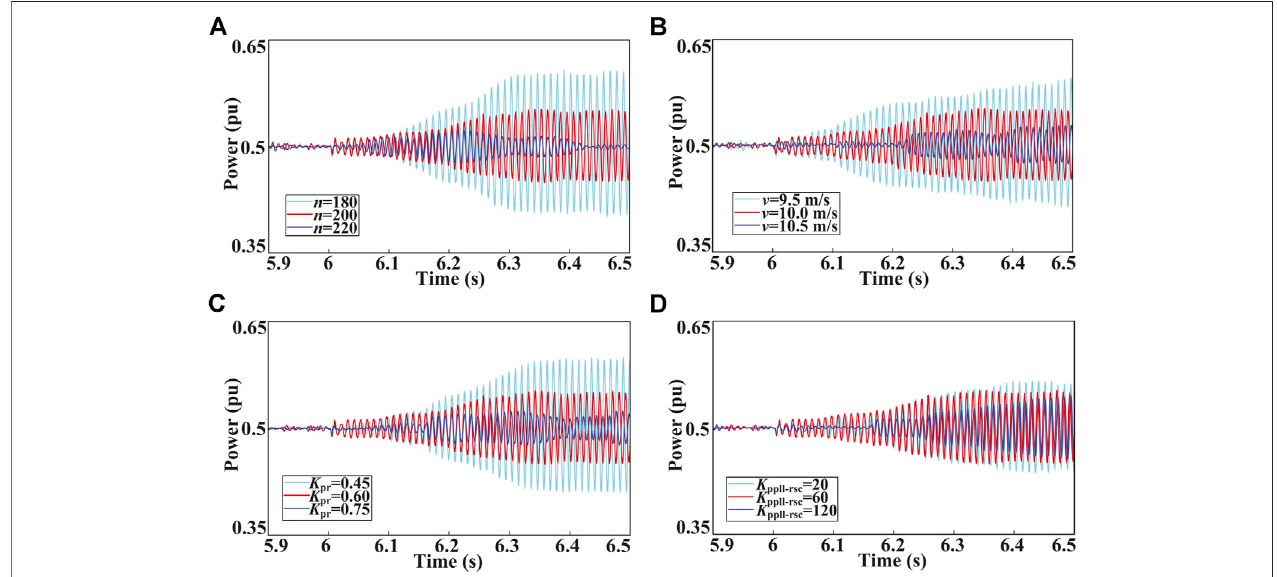
FIGURE 11 | Output power varies with (A) number of DFIG-WTs, (B) wind speed, (C) K pr , and (D) K ppll − rsc .